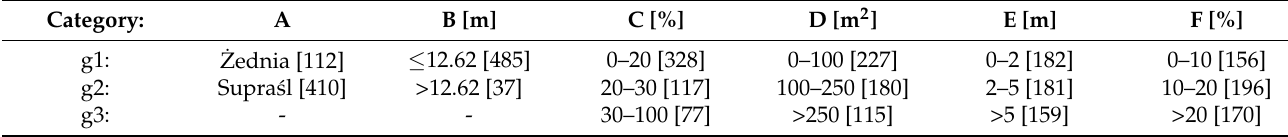
Table 2. Ranges of the variability of features grouping the circular sample plots (the counts within the considered categories are given in brackets): administrative affiliation of the site (A), radius size of the circular plot (B), proportion of gaps in the circular plot (C), variance of the area of the rectangular projection of the crown in the circular plot (D), variance of the height of the trees in the sample plot (E), and proportion of the number of trees with apex partial visibility to full visibility